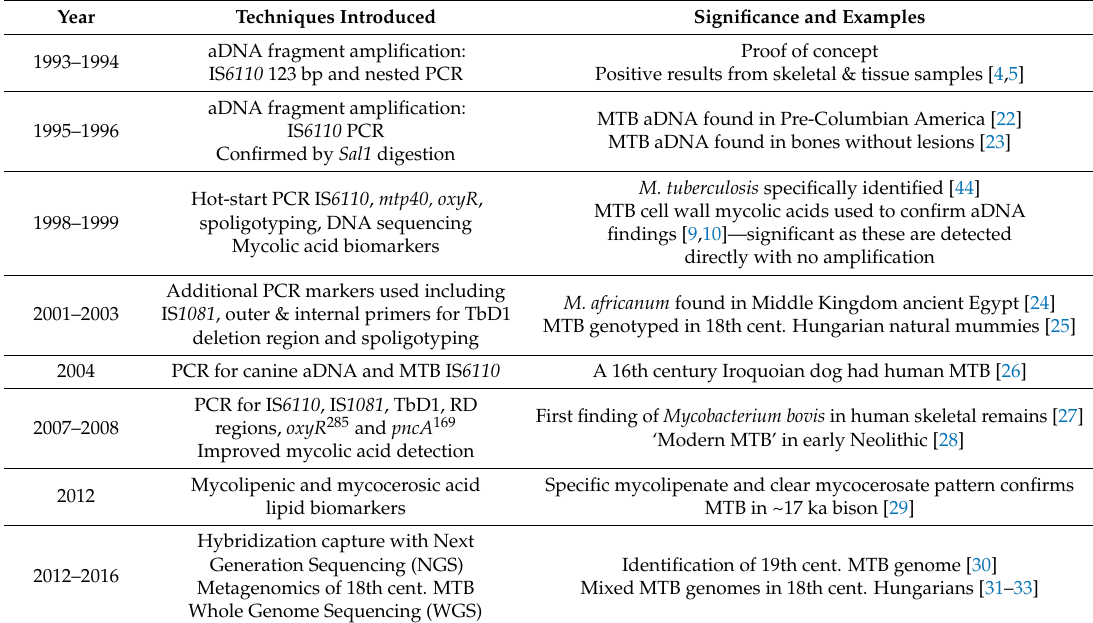
Table 1. Summary of methods used in M. tuberculosis aDNA and lipid biomarker diagnoses (See Table S1 for detailed breakdown).